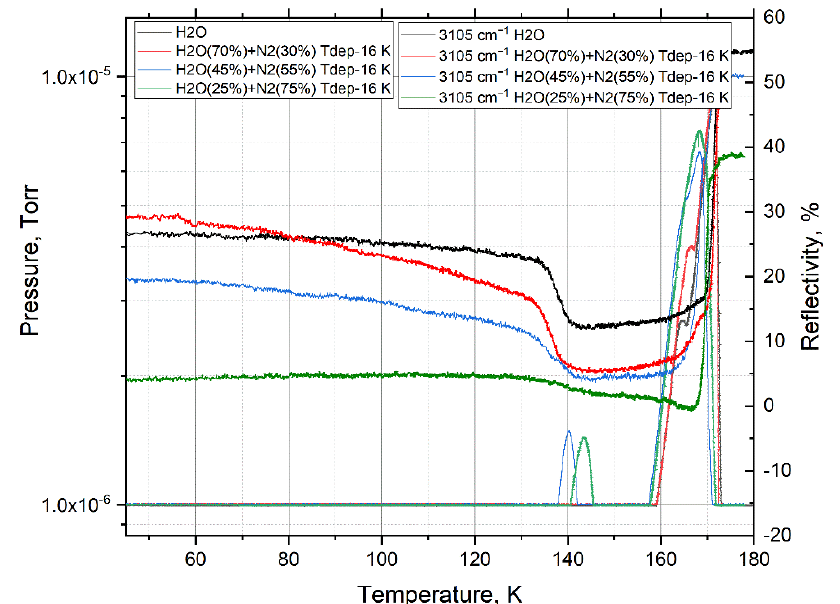
Figure 11. Thermogram of the OH vibration amplitudes and pressure in the chamber with an increase in the temperature of films of various concentrations of a mixture of water with nitrogen.